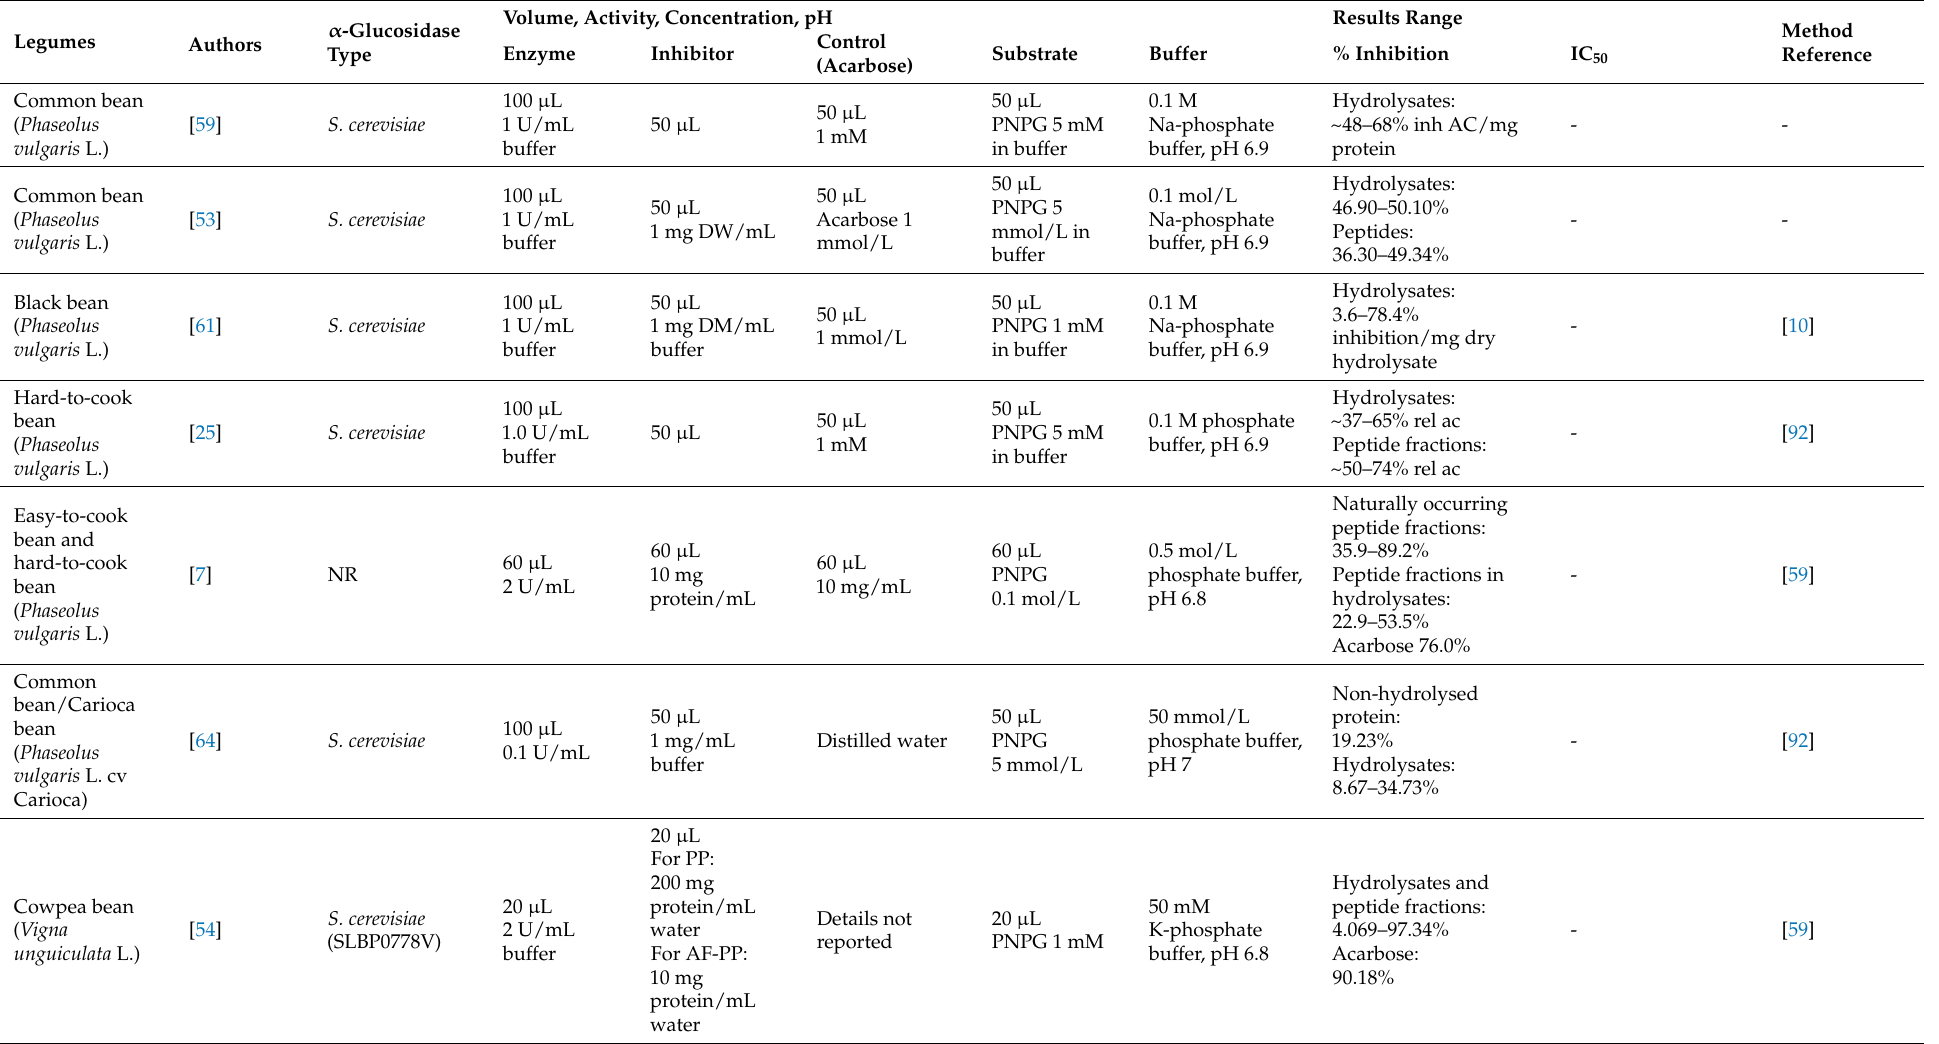
Table 5. α -Glucosidase Inhibitory